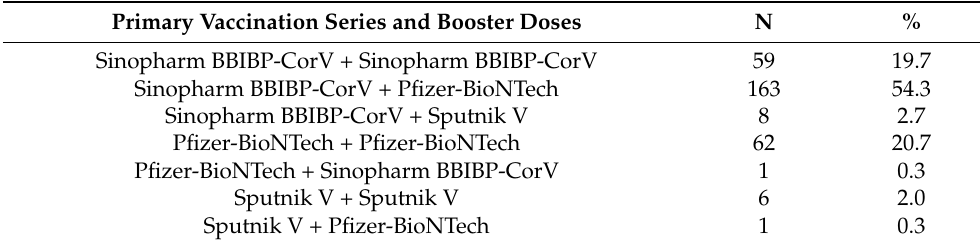
Table 2. Distribution of applied vaccine combinations (primary vaccination series and booster doses, n =